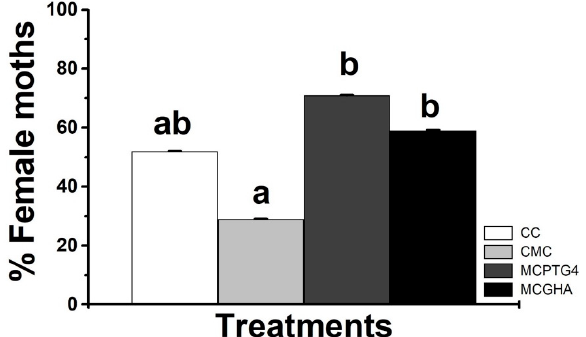
Figure 5. S. frugiperda female moths’ percentage distribution after feeding on plants treated with the different treatments. CC: Negative control, CMC: Negative control with only methylcellulose, MCPTG4: B. bassiana fungal strain PTG4 with methylcellulose, MCGHA: B. bassiana fungal strain with methylcellulose. Analysis done with Duncan’s post-hoc multiple range test ( α = 0.05) after one-way ANOVA. Graphical bars with the same letters indicate that there were no significant differences among them.